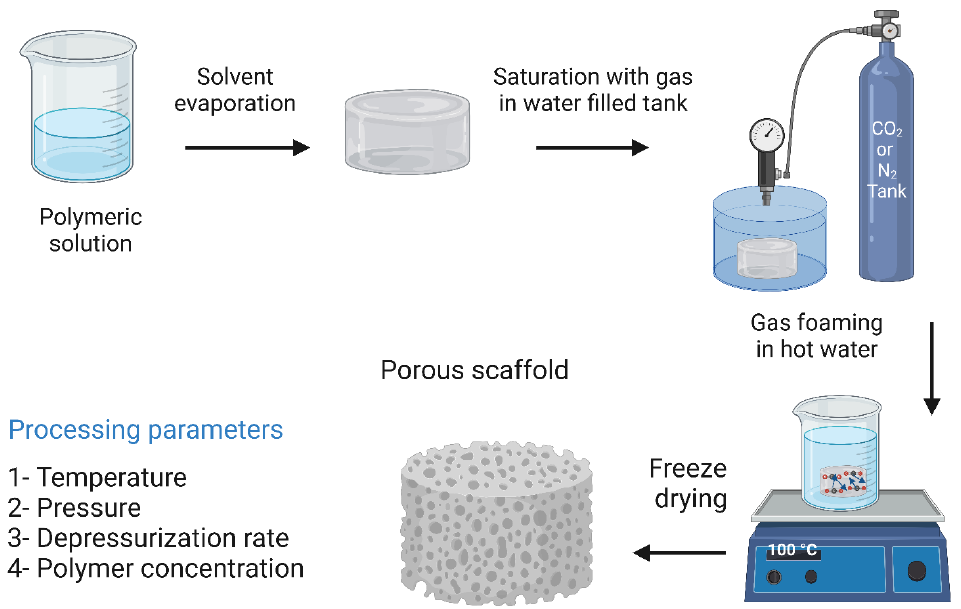
Figure 12. The gas foaming technique and its processing parameters. The image was created using Figure 12. Thegasfoamingtechniqueanditsprocessingparameters. TheimagewascreatedusingBiorender. Biorender.